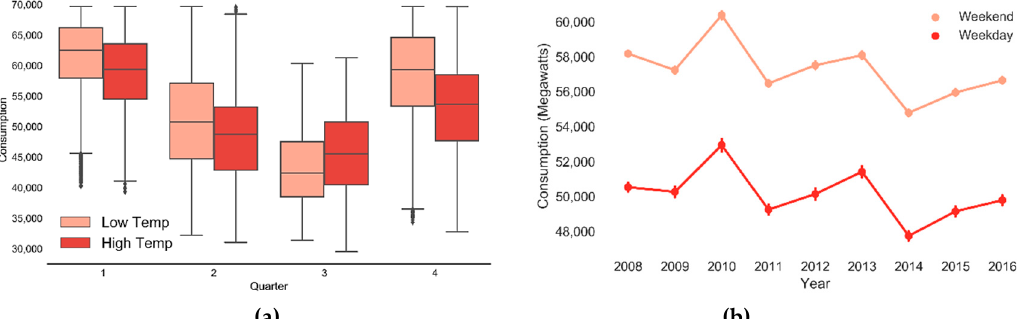
Figure 6. ( a ) Box plot of load consumption for high and low temperatures; ( b ) Factor plot of electric load consumption weekend vs. weekday.